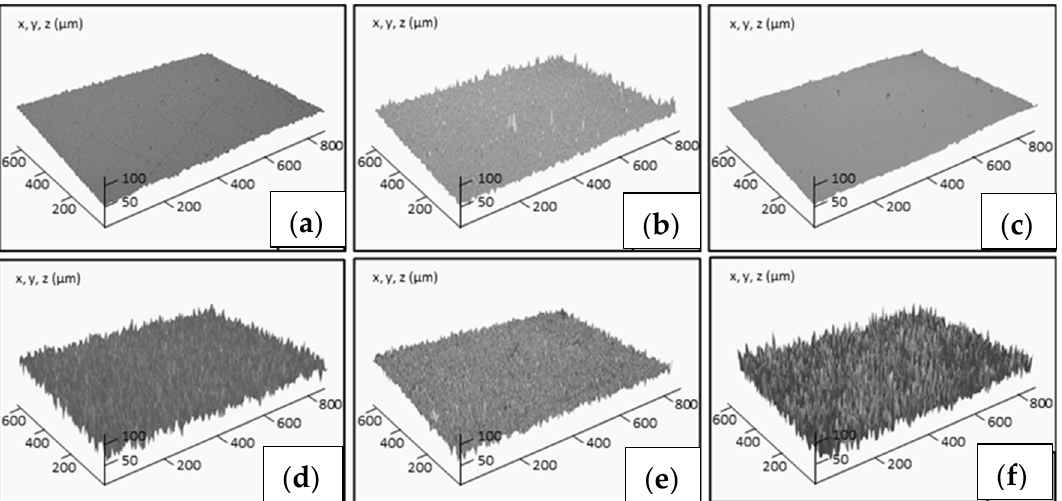
Figure 7. Surface profiles of non-treated surfaces of neat epoxy thermoset ( a ) and composites rein- forced with 10 wt% commercial TiO 2 ( b ) and commercial ZnO ( c ), and etched surfaces of nanocom- posites with 6 wt% commercial TiO 2 ( d ), commercial ZnO ( e ) and recycled ZnO ( f ).